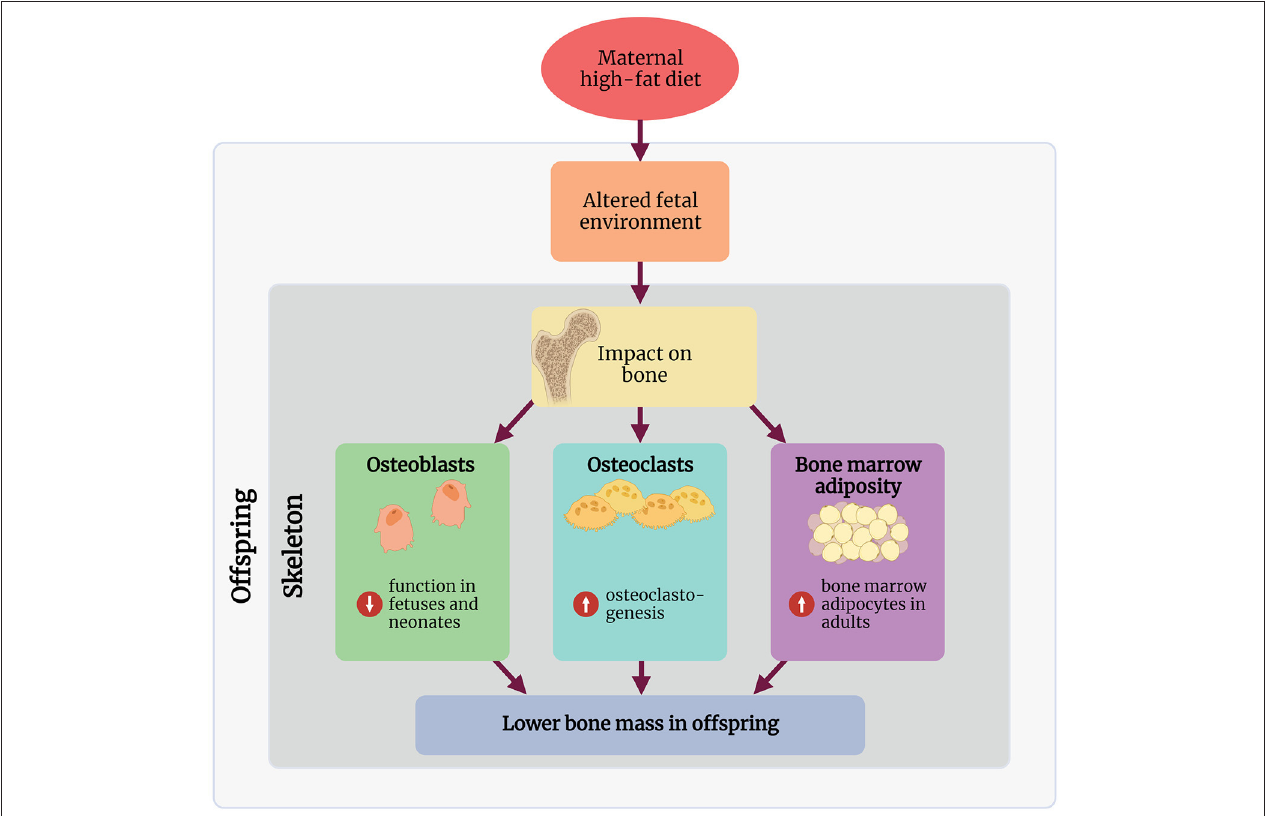
FIGURE 1 | Summary of the proposed mechanisms through which maternal high-fat diet affects the skeleton in the offspring. Created with